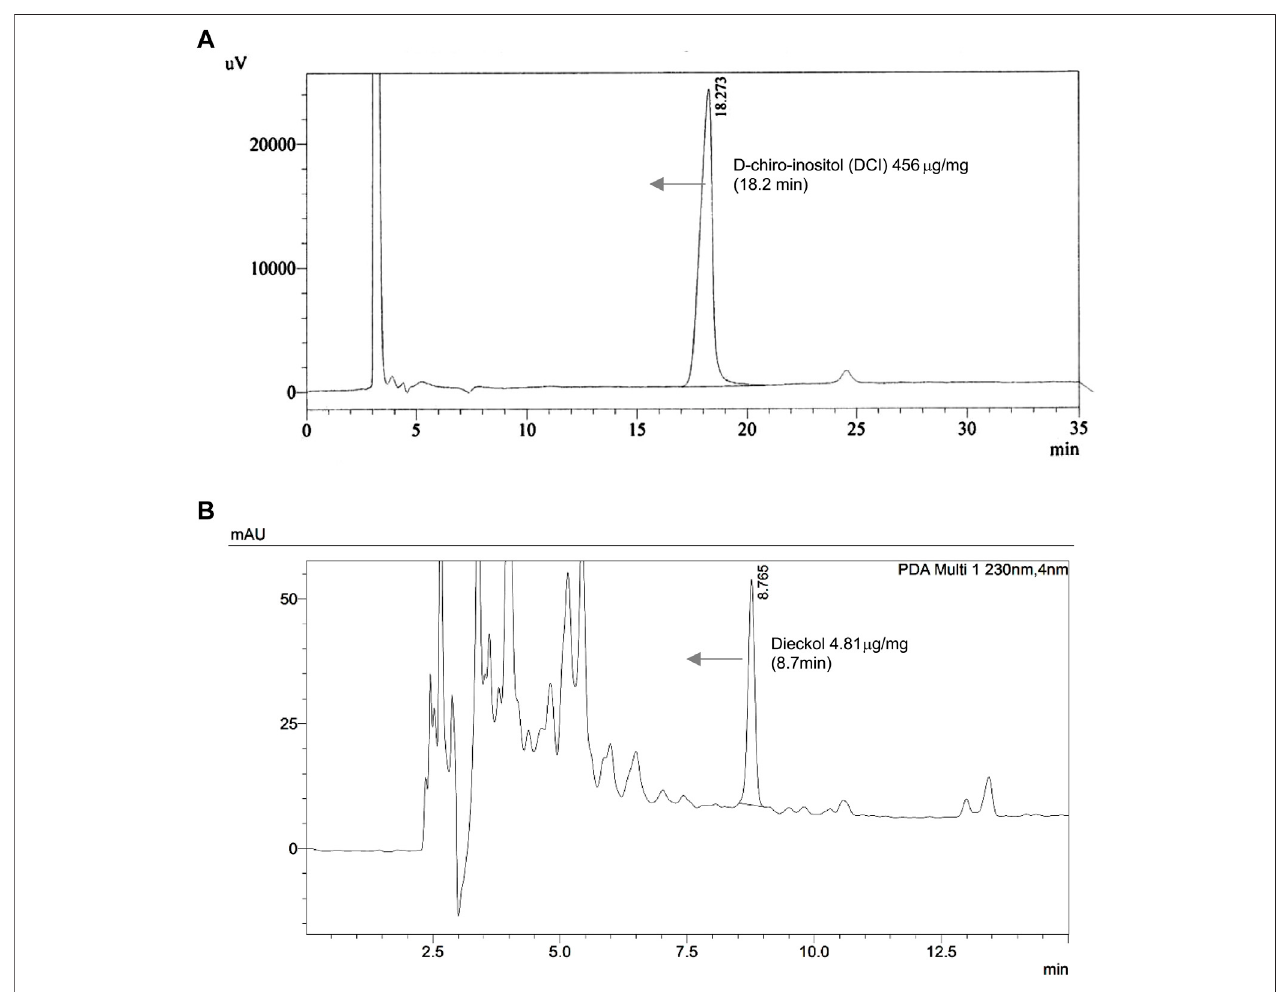
FIGURE 1 | The chromatograms of the (A) d -chiro-inositol and (B) Ecklonia cava K. aqueous extract at refractive index (RI) Detector and 230 nm.